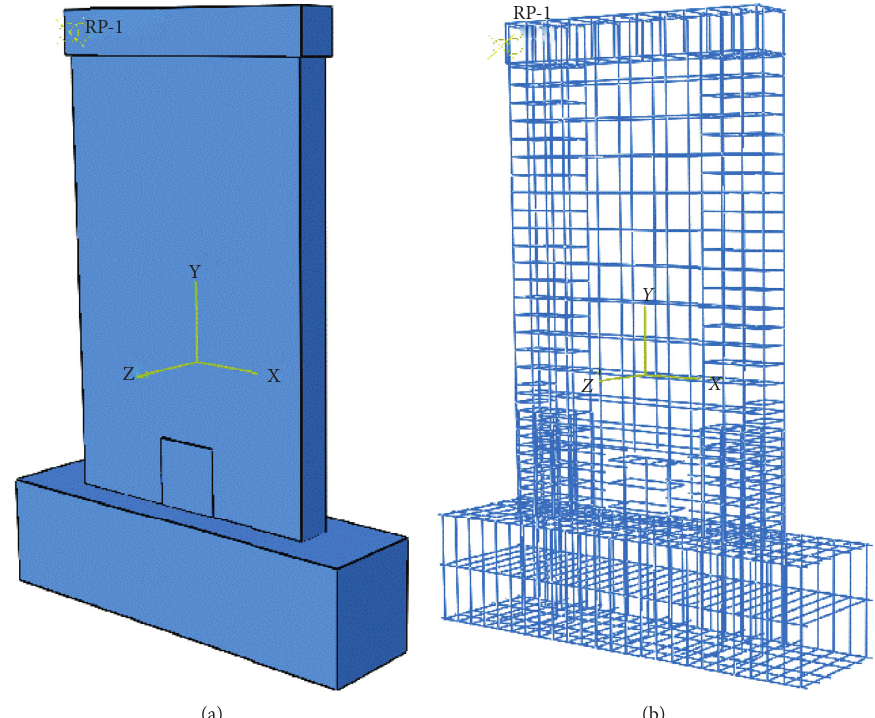
Figure 8: Finite element models: (a) shear wall; (b) reinforcement bars.